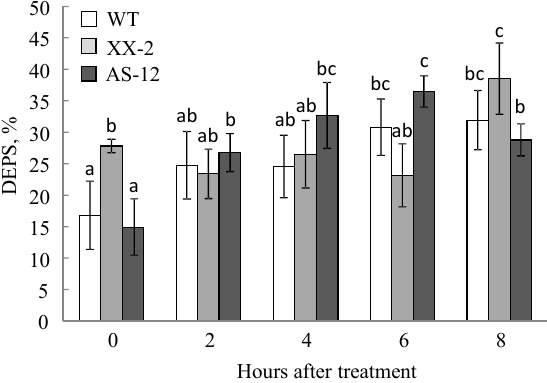
Figure 4. De-epoxidation state (DEPS) of leaves of WT, XX-2, and AS-12 Arabidopsis thaliana plants grown at 90 µ mol m − 2 s − 1 (0 h) and after 2–8 h of moderately high light (400 µ mol m − 2 s − 1 ). Data are presented as mean ± SE of values from three independent experiments (n = 3 for each experiment). Significant differences between mean values (ANOVA, Duncan’s test, p < 0.05) are indicated by different letters (a, b, c). The same or double letters (ab, bc) indicate no significant differences between the means.